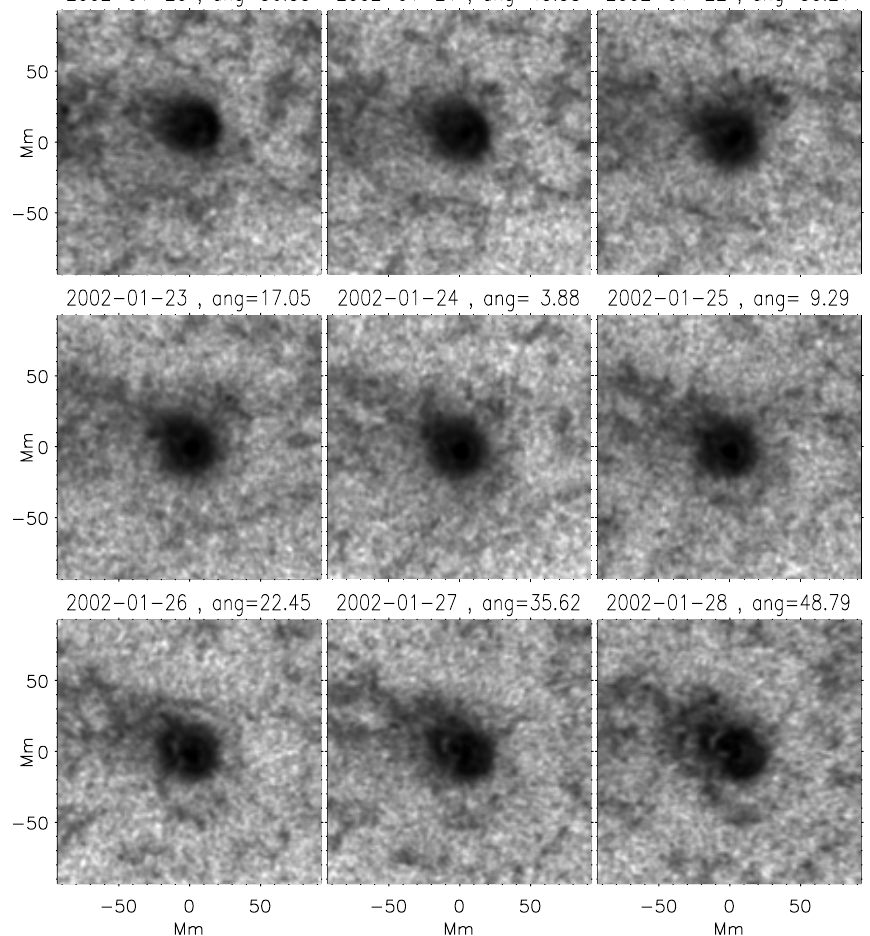
Fig. 1. Acoustic power estimated from the line-of-sight velocity data for the NOAA AR9787 region. The data are taken at 9 subsequent snapshots as the sunspot travels from 56 ◦ West to 61 ◦ East on the solar surface. The data are frequency-filtered with the filter frequency band centred on 3mHz. The images show little apparent variation in the centre of the